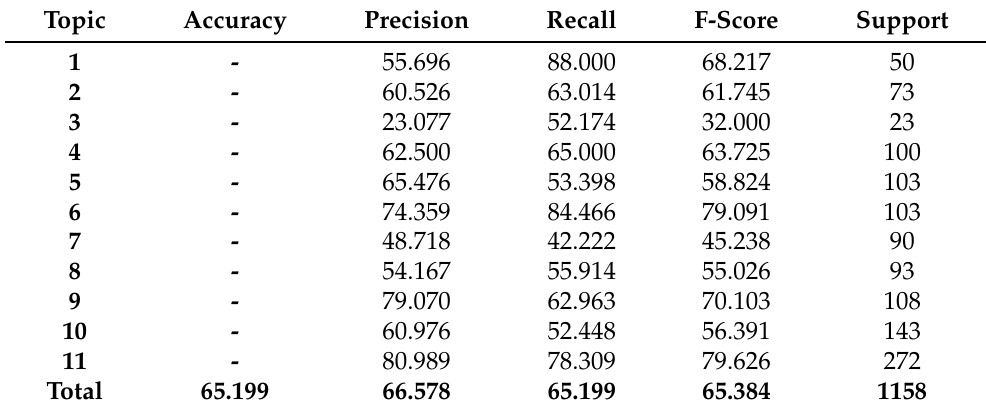
Table 8. Logistic Regression with Word2Vec-500dim model